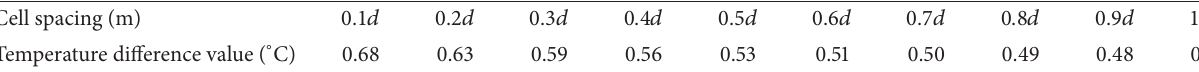
Table 2: Changes in temperature differences with varying cell spacings.